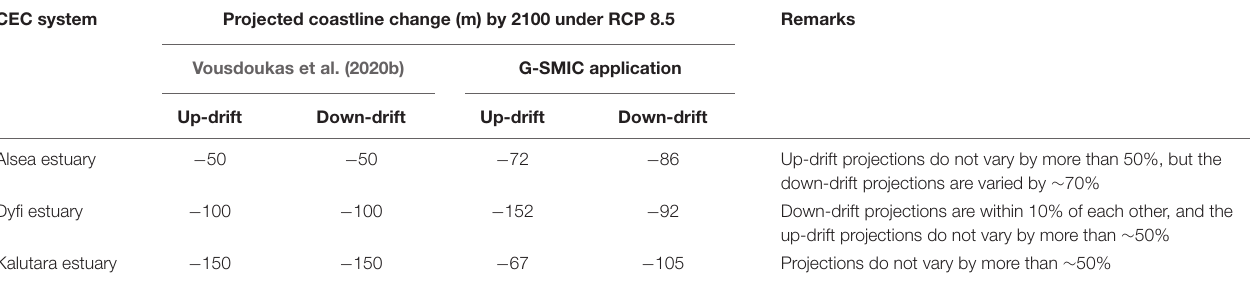
TABLE 3 | Comparison of projected coastline change by 2100 with the results presented in Vousdoukas et al. (2020b) (for RCP 8.5). CEC system Projected coastline change (m) by 2100 under RCP